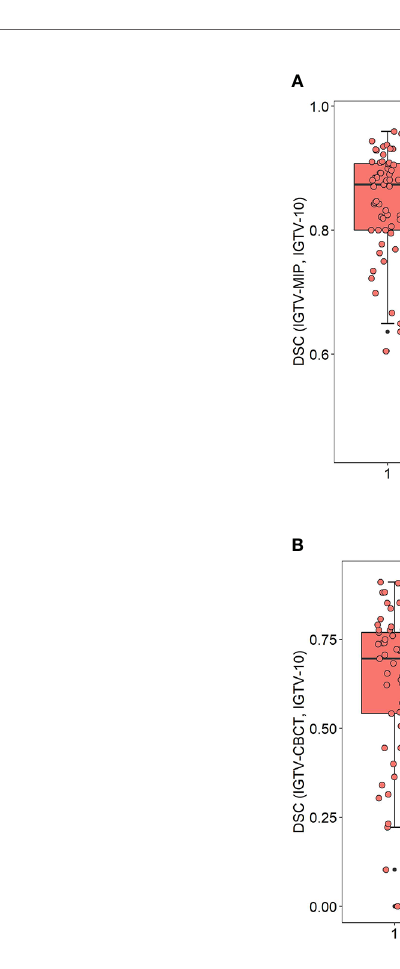
FIGURE 2 | Distributions of DSC. (A) The distribution of DSC (IGTV-MIP, IGTV-10) grouped by position of cancer. (B) The distribution of DSC (IGTV-CBCT, IGTV- 10) grouped by position of cancer. DSC, Dice ’ s similarity coef fi cient; IGTV-10, internal gross target volume from 10 phases of four-dimensional computed tomography; IGTV-CBCT, internal gross target volume-cone beam computed tomography; LUL, left upper lobe; LLL, left lower lobe; RUL, right upper lobe; RML, right middle lobe; RLL, right lower